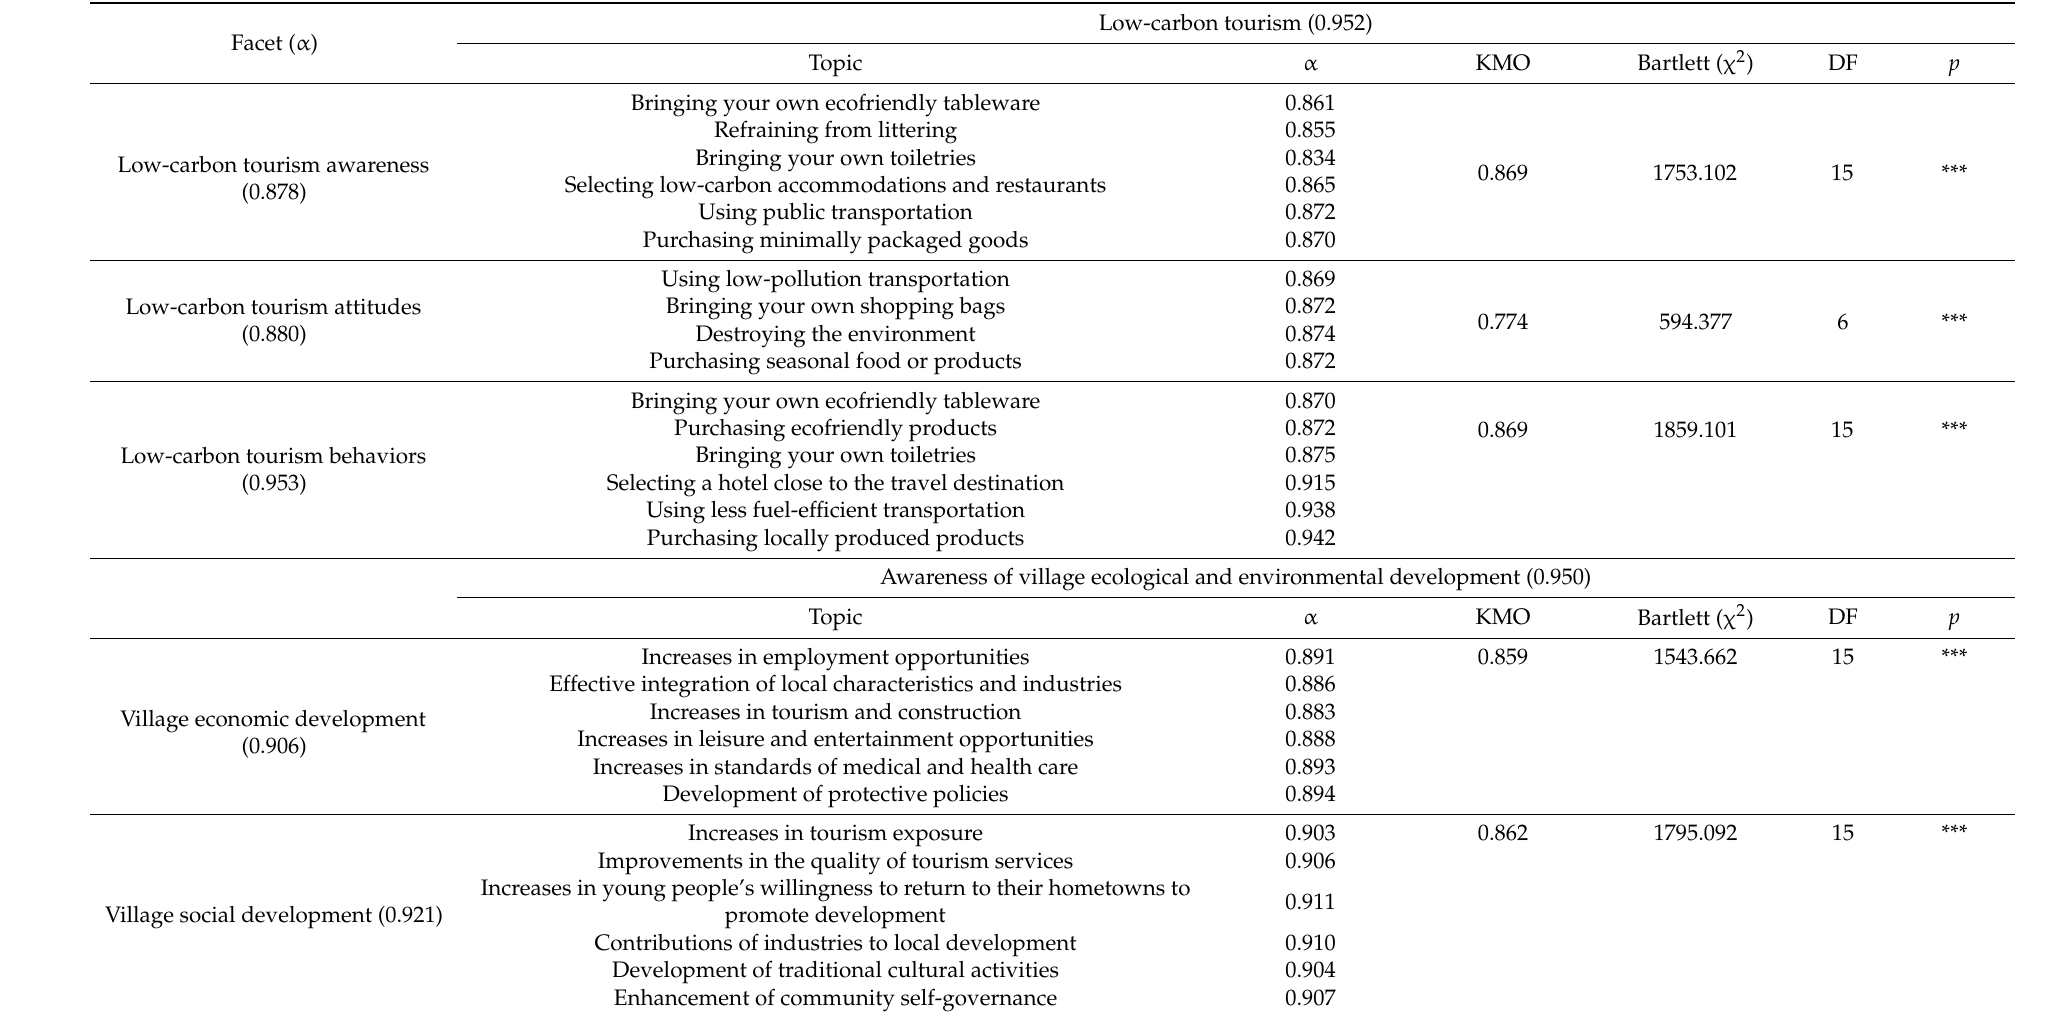
Table 1. Overview of experts’ and respondents’ backgrounds and questionnaire reliability